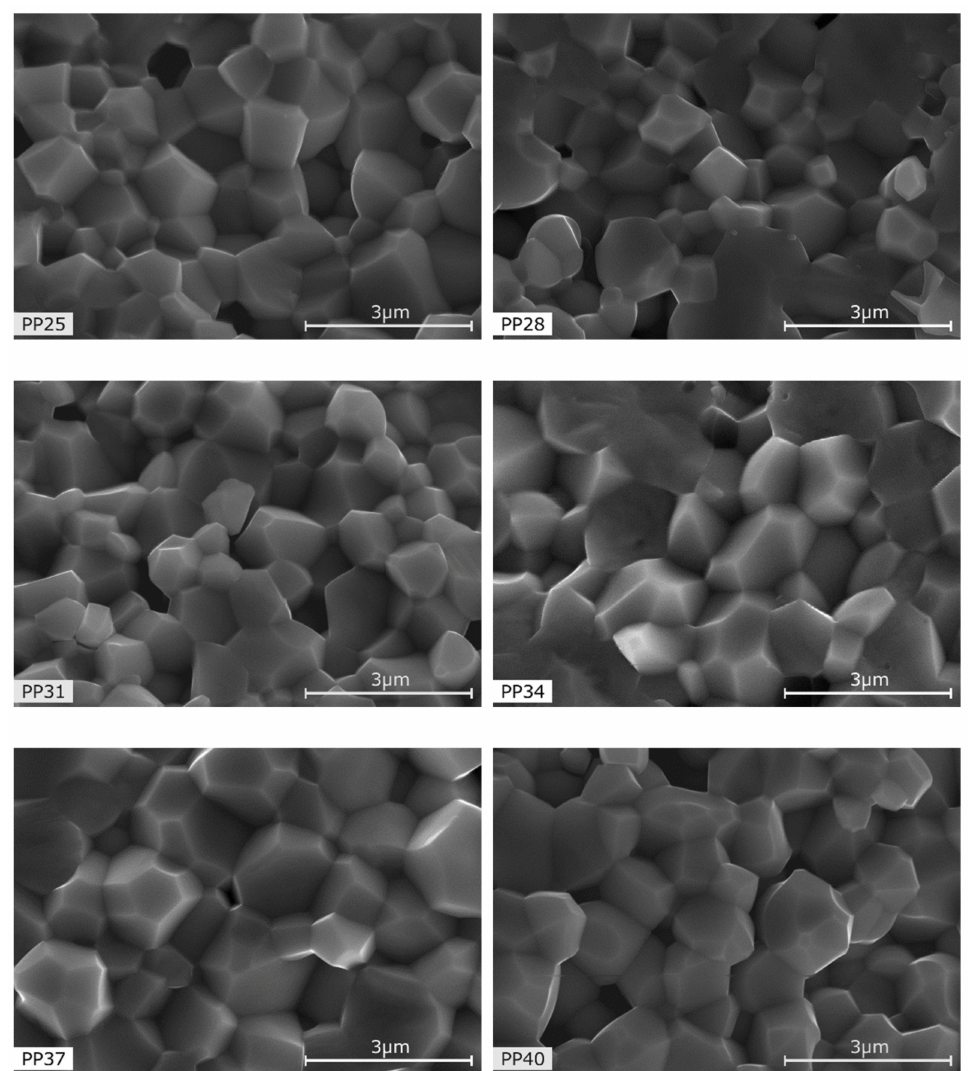
Figure 2. SEM microstructure of PP ceramics for: PP25 for x = 0.25, PP28 for x = 0.28, PP31 for x = 0.31, PP34 for x = 0.34, PP37 for x = 0.37, PP40 for x =